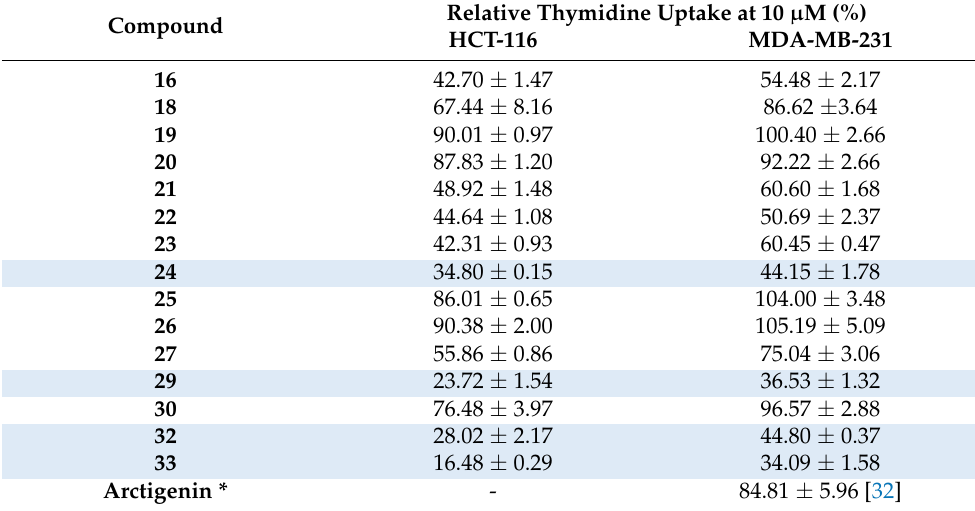
Table 1. Anti-proliferative activities when cells treated with compound (10 µ M). Values are given as the average ± standard error of three experimental replicates. Most active compounds, selected for IC 50 determination, in highlighted rows.